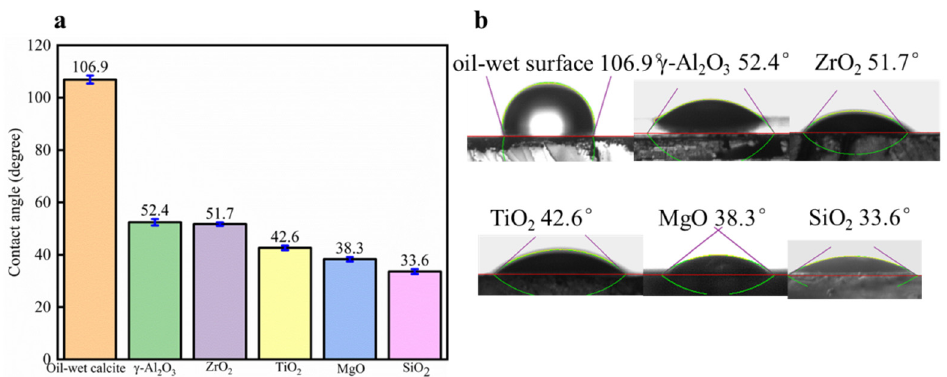
Figure 14. The effects of the different nanofluid species on oil-wet calcite wettability (25 °C). ( a ) Contact angle histogram; ( b ) Measurement figure.